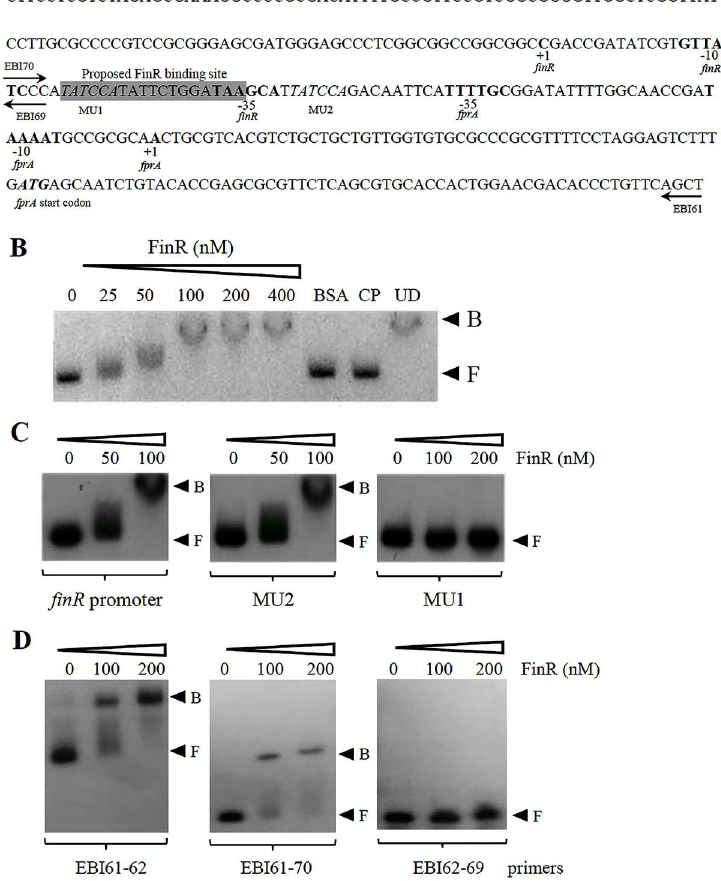
Fig 4. Characterization and binding of purified FinR to the finR-fprA promoter. (A) Nucleotidesequence showingthe finR - fprA promoter structure. +1 indicates the transcriptional start site, andthe bold sequencesare the putative -35 and -10 promoter motifs. CAT and ATG are the translational start codonsof FinR and FprA, respectively. The box shadedgray representsthe proposedFinR bindingsite. (B), (C), and (D) Electrophoretic mobilityshift assay using purifiedFinR. A 32 P –labeledDNA fragment (B), mutagenized MU1 and MU2 fragments (C), or the promoter fragments (EBI61-62), with (EBI 61–70)and without(EBI 62–69)proposed FinR bindingsite (D) spanning the finR-fprA promoterwas incubatedwith increasing amountsof FinR. BSA represents an unrelated protein(2.5 μ g BSA). CP andUD signify the cold probe(100 ng unlabeledpromoter fragment) and unrelatedDNA (1 μ gof pUC18plasmid),respectively, that were addedto the bindingreaction mixture containing100 nM FinR. F and B indicatefree and boundprobes,